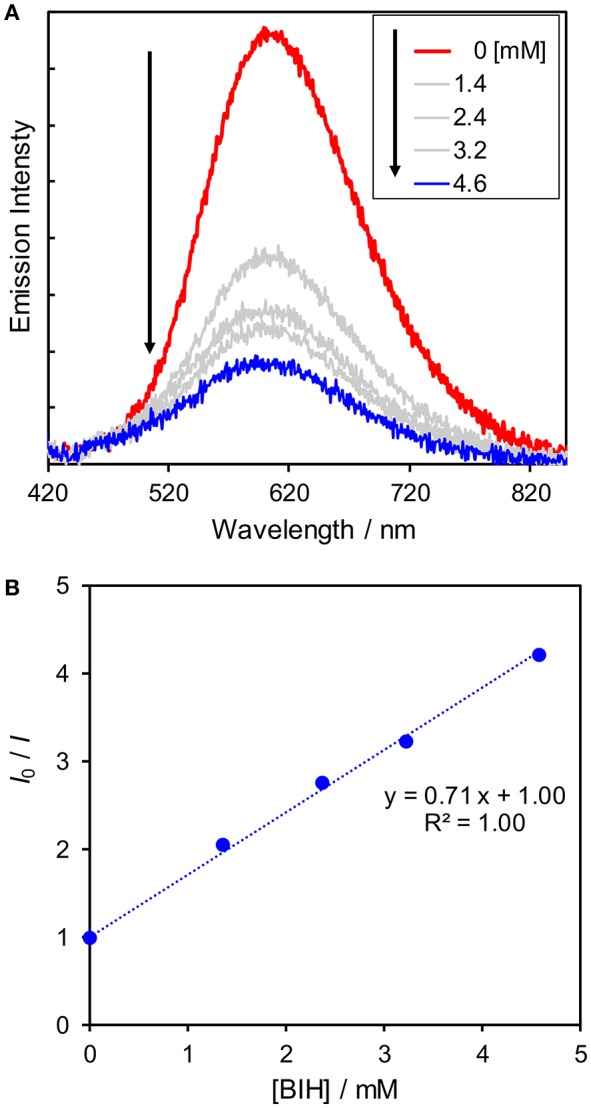
(A) Emission spectra (excitation 410 nm) of Cu(dppb) in MeCN-TEOA under an Ar atmosphere in the presence of various amounts of BIH and (B) the Stern-Volmer plot using emission intensity (I) and the emission intensity without any BIH (I0).